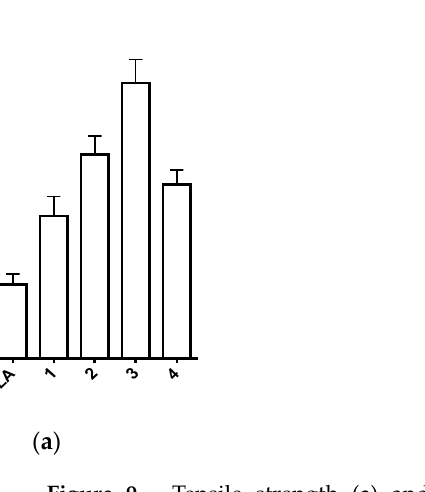
Figure 8. Stress-strain curves for electrospun materials from PEO or PLA ( a ), and for the PEO/PLA/BW series ( b ).